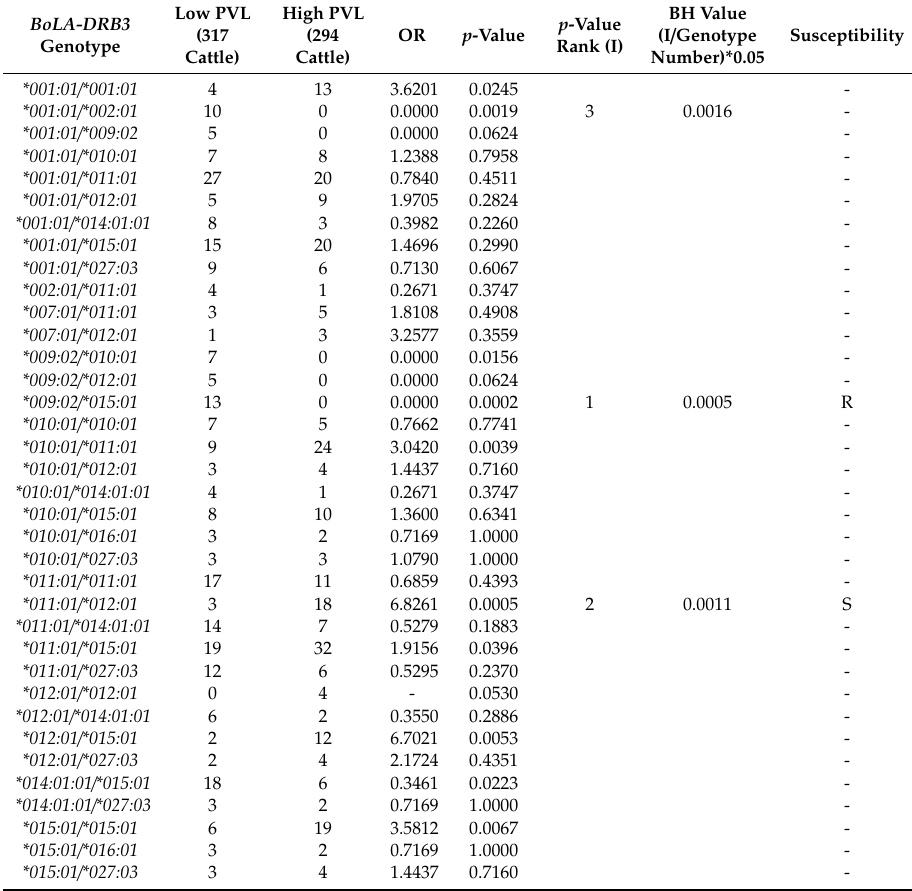
Table 7. Fisher’s exact test based association analysis of BoLA-DRB3 genotypes in low PVL and high PVL